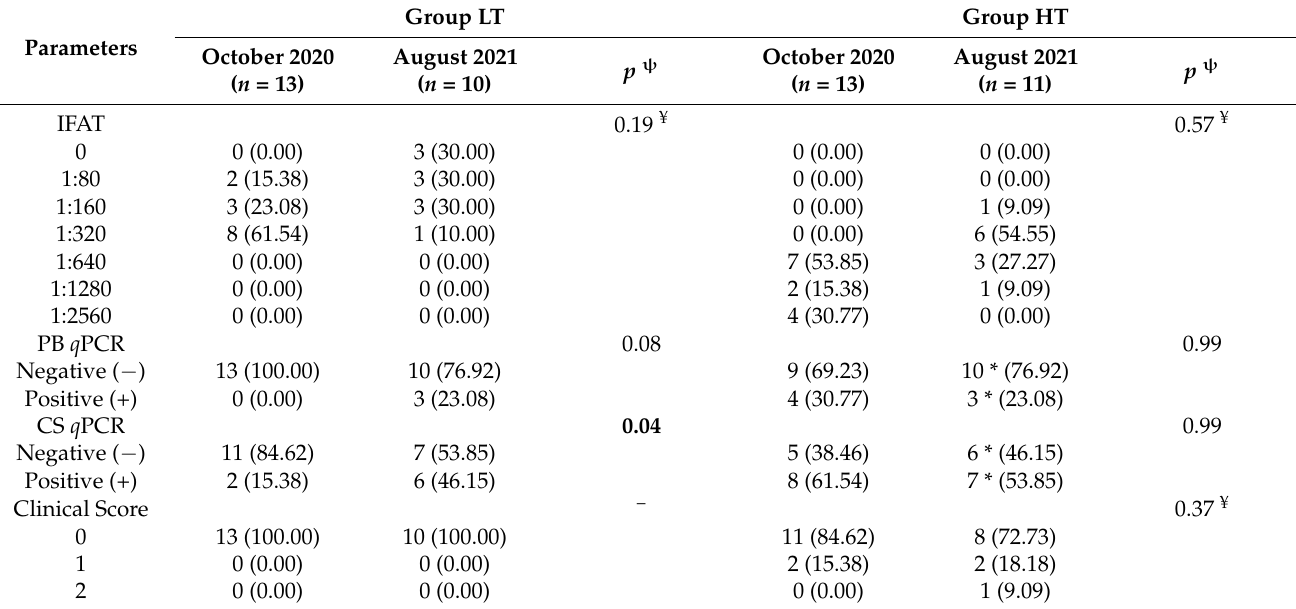
Table 5. Comparison of diagnostic tests results and clinical score between October 2020 and August 2021 in dogs of the low titre (LT) and high titre (HT)